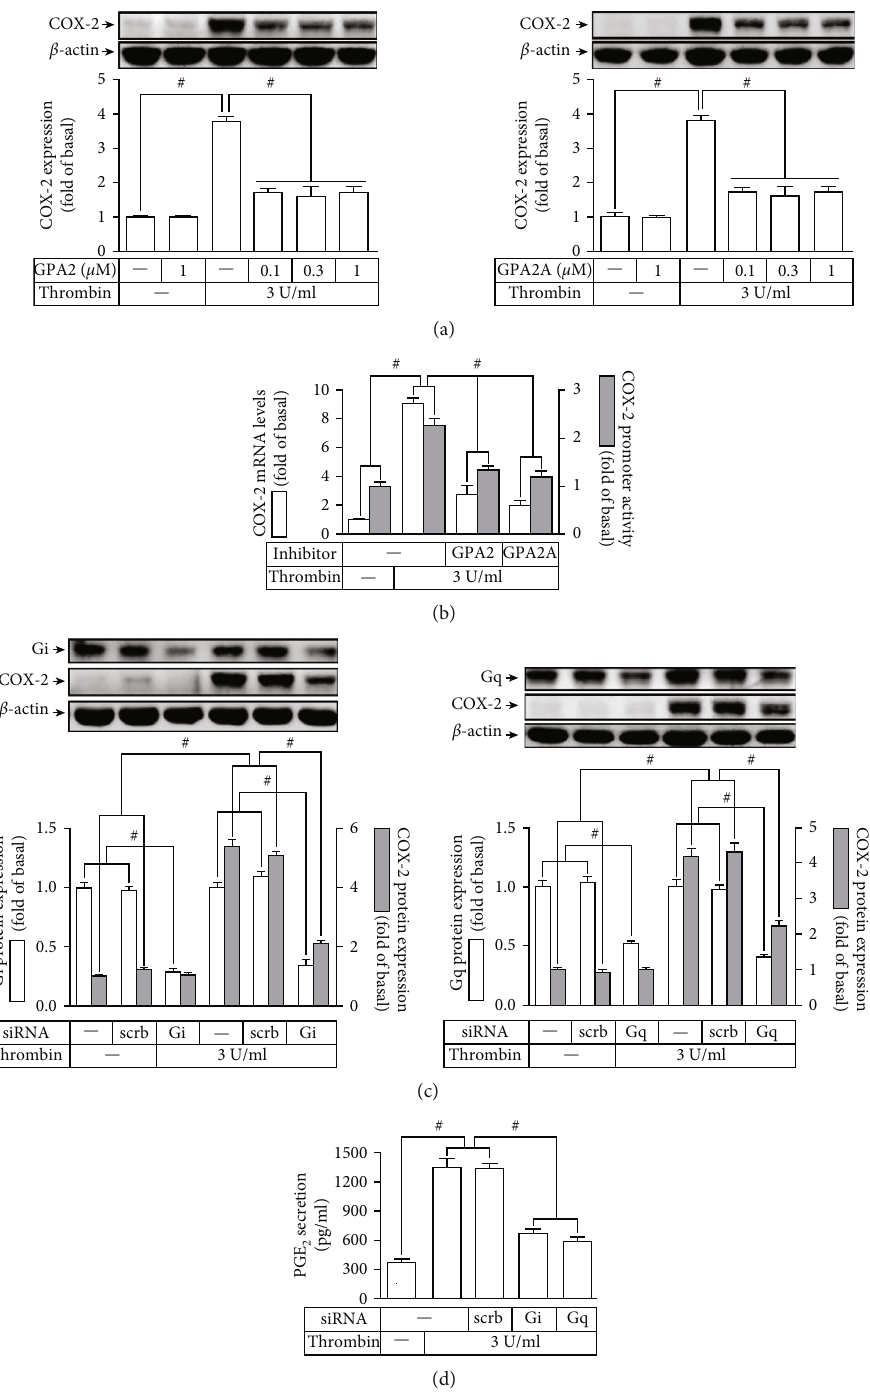
Figure 2: Thrombin enhances COX-2 expression via G-coupled receptor Gq and Gi/o subunit. (a) Cells were pretreated with GPA2 or GPA2A for 1h and then incubated with thrombin for 6 h. The levels of COX-2 protein were determined. (b) Cells were pretreated with GPA2 (1 μ M) or GPA2A (1 μ M) for 1 h, and then incubated with thrombin for 4 h. The mRNA levels and promoter activity of COX-2 were determined. (c) Cells were transfected with scrambled, Gq α , or Gi α siRNA and then incubated with thrombin for 6 h. The levels of Gq α , or Gi α , and COX-2 protein were determined. (d) The media saved from (c) were used to determine the levels of PGE Data are expressed as mean ± S : E : M : of three independent experiments. # P < 0 : 05 , as compared with the control or pretreatment with inhibitor indicated in the fi